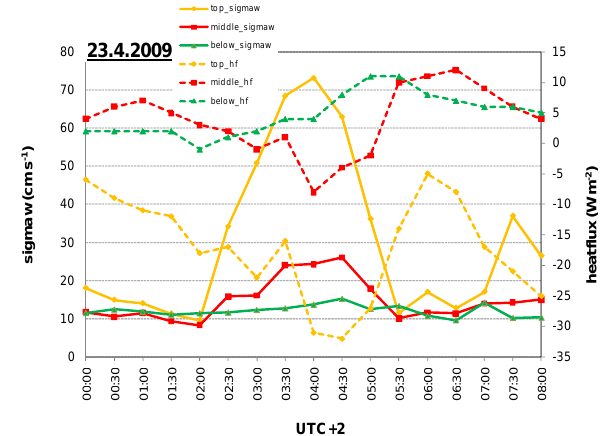
Figure 2c. Time series of σ w (cms − 1 , solid lines) and sensible heat flux (Wm − 2 , dashed lines) on 23 April 2009, at the three levels of the